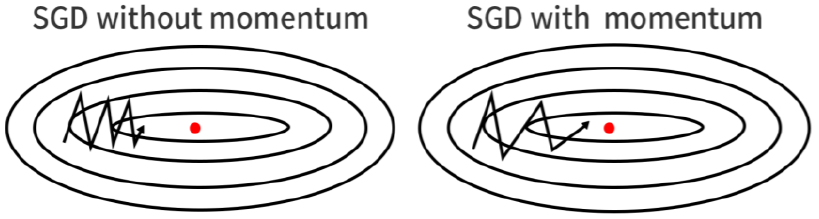
Figure 2. Comparison of SGD algorithms with and without momentum